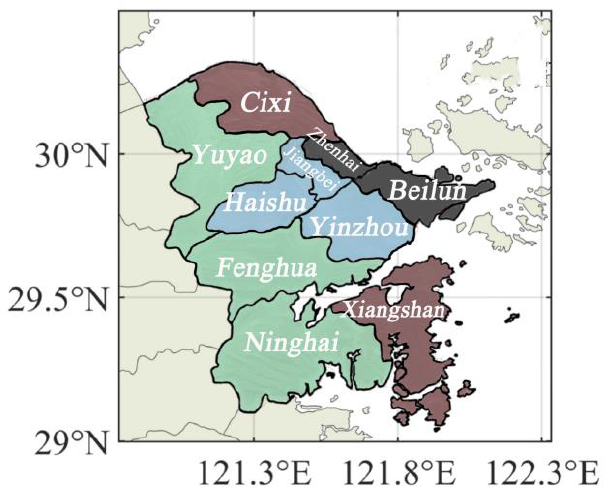
Figure 9. Zoning map of Ningbo districts and counties.